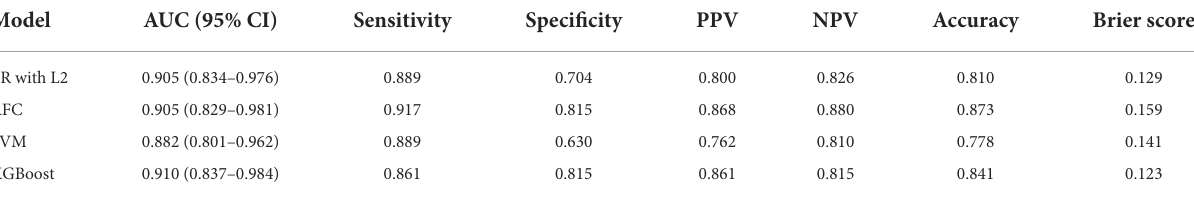
TABLE 2B Scores of each “Late” model on the test set.